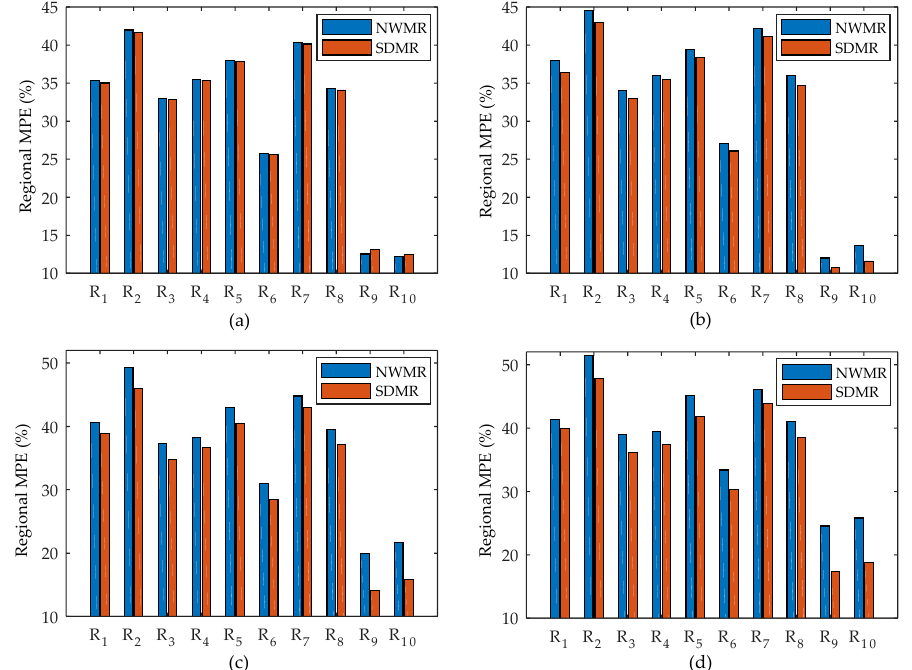
Figure 9. Error-bar plots for regional MPE for NWMR and SDMR: ( a ) β = 0.05; ( b ) β = 0.2; ( c ) β = 0.5; ( d ) β = 0.7.